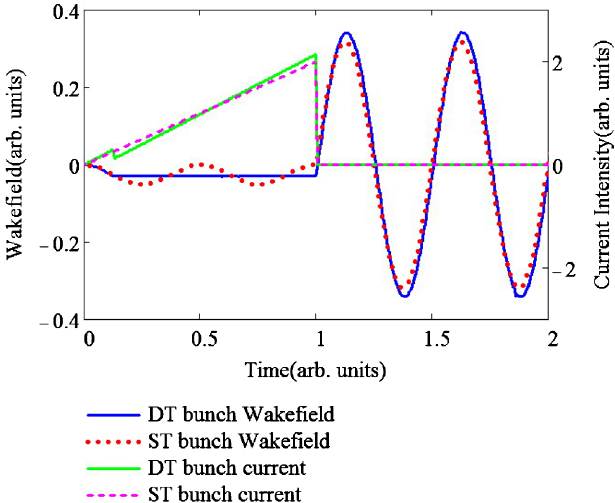
FIG. 1. Wakefields for the ideal DT and ST bunches traversing a single mode wakefield